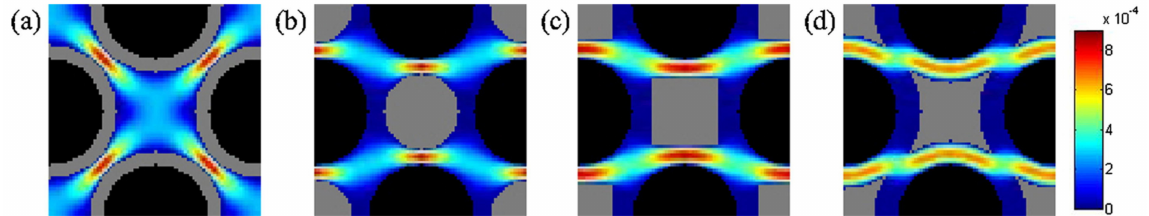
Figure 24. Distribution of hydrate and pore-scale velocity field in the porous media model reprinted from [63] with permission from Elsevier. ( a ) Hydrate coats grain surface; ( b – d ) hydrate occupies pore centers with different micromorphology. The gray is regarded as hydrate. The color fluid is regarded as a velocity field obtained by